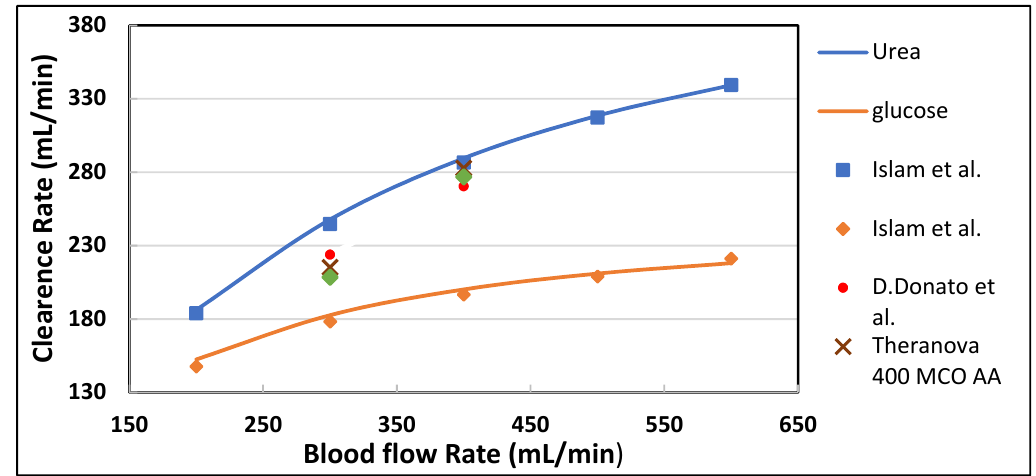
Figure 5. The model predicted (solid lines) vs. in vivo and in silico (symbols) solute clearances plotted against varying blood flow rate at Q D = 500 mL/min.